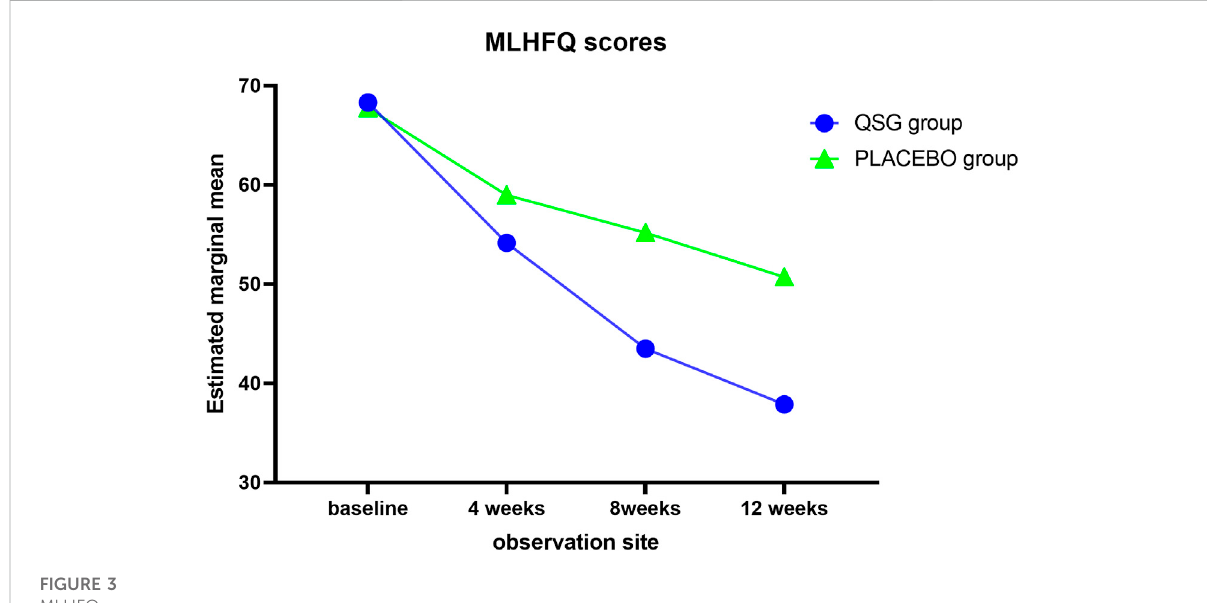
FIGURE 3 MLHFQ scores.